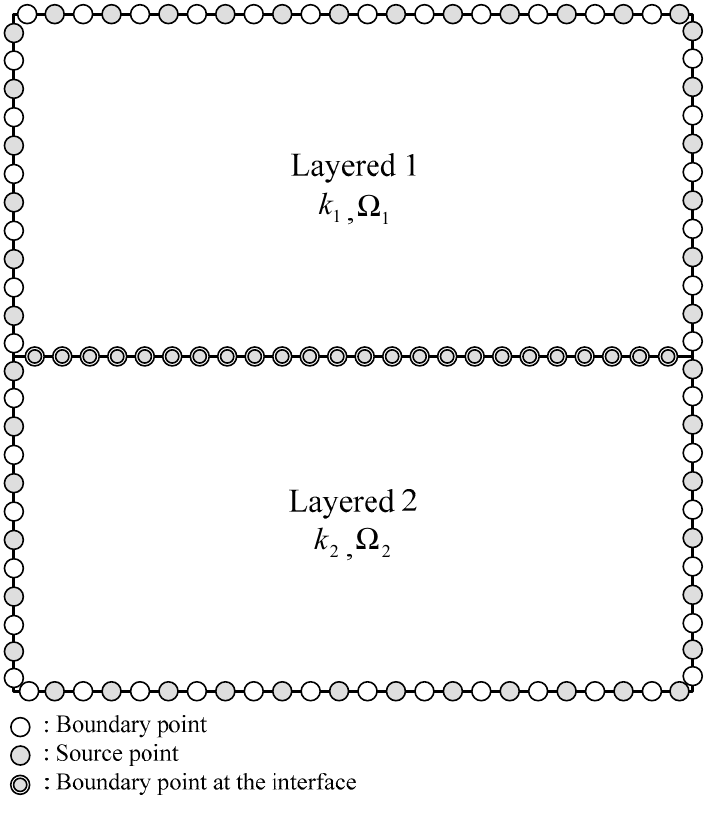
Figure 12. Illustration of the collocation of boundary and source points.